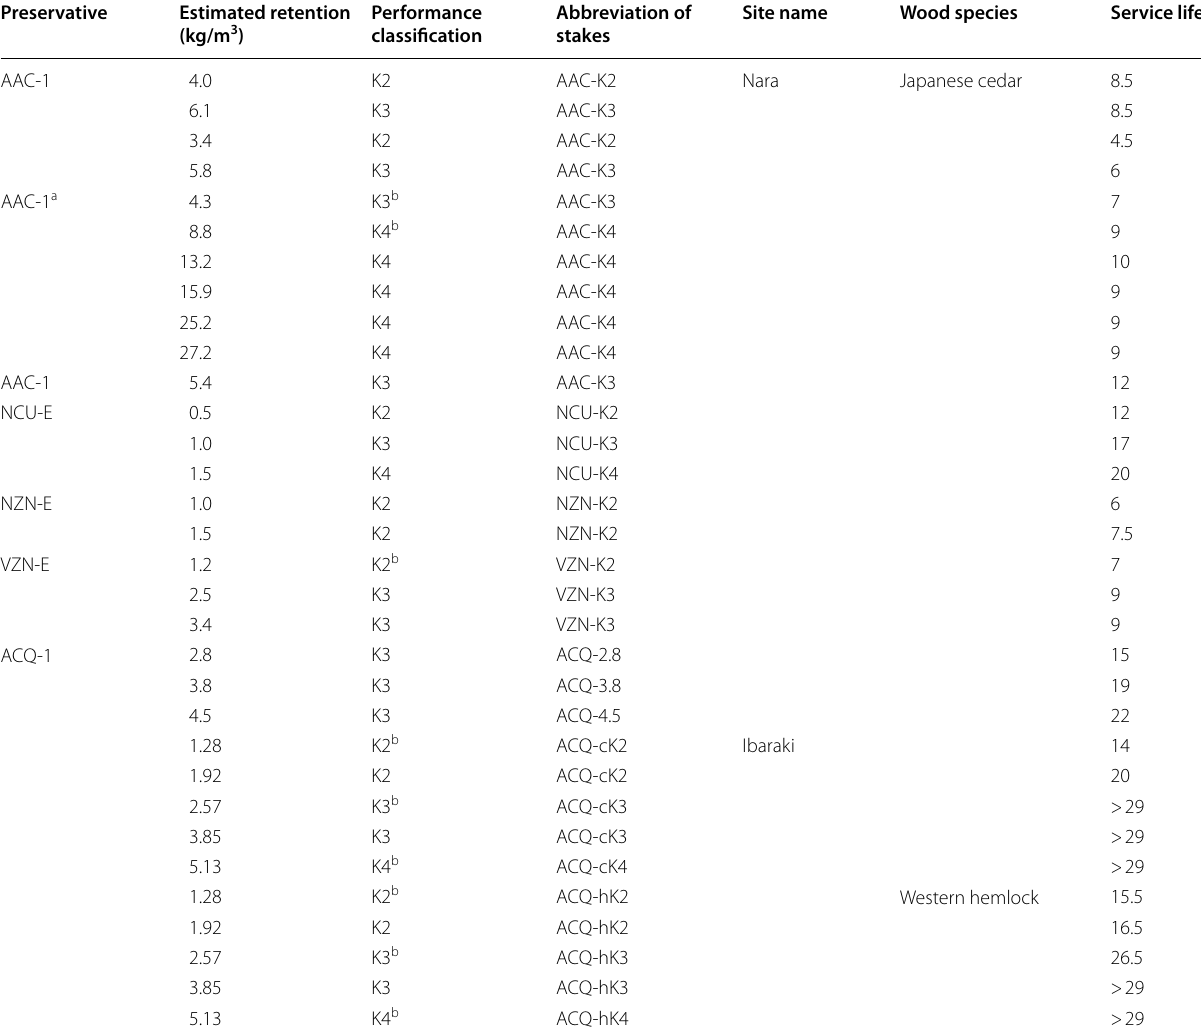
Table 1 Characteristics of stake group and their apparent service lives Preservative